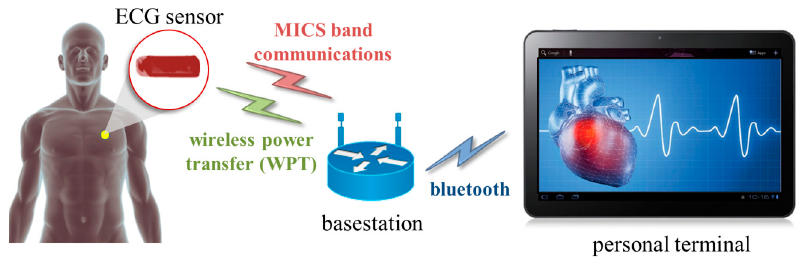
Figure 1. Electrocardiogram (ECG) monitoring system diagram.